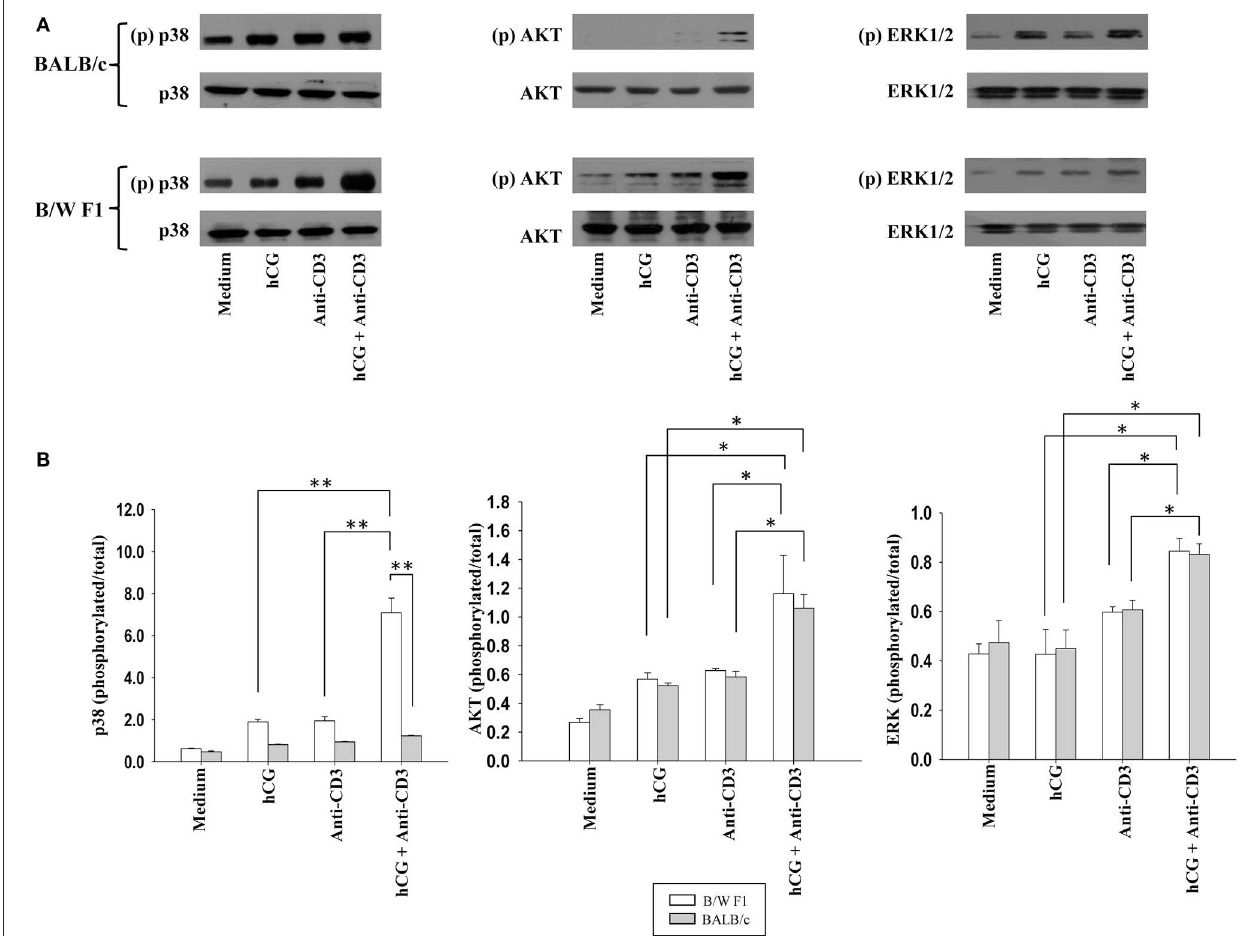
FIGURE 5 | Assessment of the phosphorylation of signaling intermediates upon TCR and hCG-mediated signaling. Splenocytes from B/W F1 or BALB/c mice were incubated with Medium, hCG, anti-CD3 antibodies or hCG + anti-CD3 antibodies. (A) Western blots were employed to determine phosphorylated (p) and total p38, AKT, and ERK 1/2. Representative blots of 3 independent experiments are shown. (B) Ratios of respective phosphorylated-to-total signal band intensities as assessed by ImageJ analysis from 3 independent experiments. Bars represent arithmetic means ± SEM of band intensities. * p < 0.05, ** p <